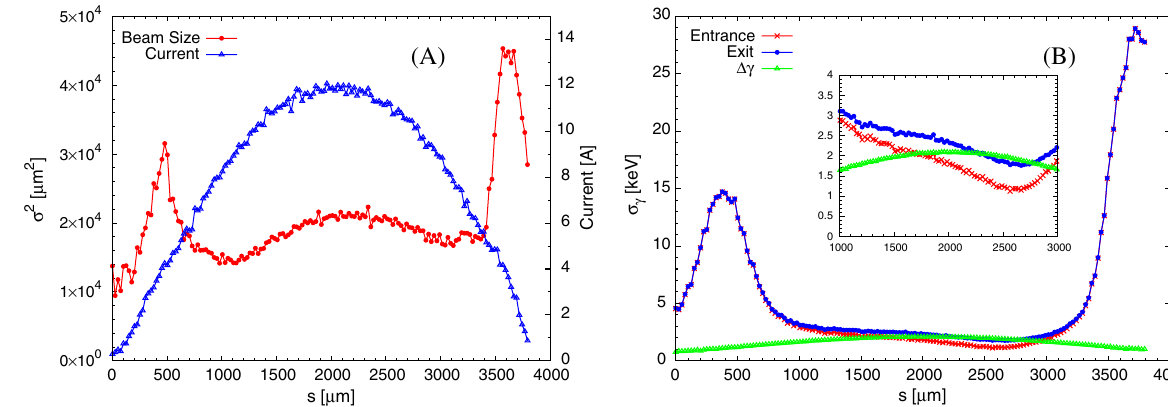
FIG. 4. Simulation results of the parameters’ distributions along the electron beam. (A) Beam current (triangles) and transverse beam size (dots). (B) Local energy spread before (crosses) and after (dots) the modulator and energy modulation amplitude (triangles) for ¼ 5 kW P seed